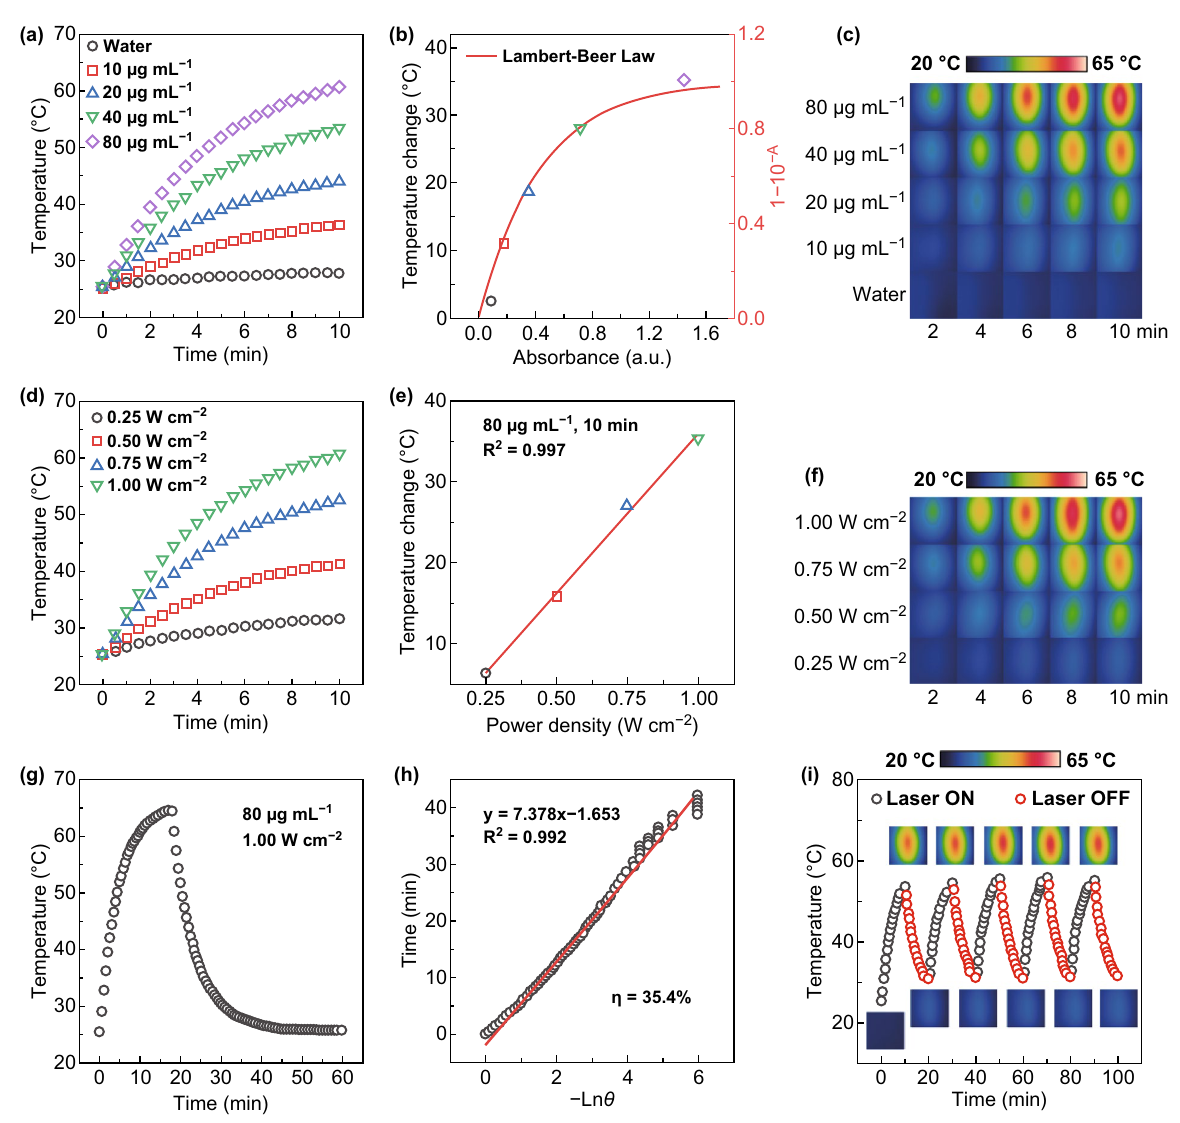
Fig. 2 Photothermal effect of IID-ThTPA NPs. a Photothermal heating curves of IID-ThTPA NPs with different concentrations (671 nm, 1.00 W cm −2 ). b Plot of the temperature changes of IID-ThTPA NPs versus the absorbance at different concentrations with a fitted curve derived from Lambert–Beer law. c Infrared thermographs of IID-ThTPA NPs with different concentrations under laser irradiation at various time points (671 nm, 1.00 W cm −2 ). d Photothermal heating curves of IID-ThTPA NPs (80 μg mL −1 ) under 671-nm laser irradiation with different power densities. e Plot of the temperature changes of IID-ThTPA NPs versus the laser power densities with a linearly fitted line. f Infrared thermo- graphs of IID-ThTPA NPs (80 μg mL −1 ) under 671-nm laser irradiation with different power densities at various time points. g Photothermal heating curve to calculate the photothermal conversion efficiency. IID-ThTPA NPs (80 μg mL −1 ) were irradiated by a 671-nm laser with a power density of 1.00 W cm −2 to reach a temperature plateau; then, the laser was shut off and the temperature was allowed to cool to room tempera- ture naturally. h Plot of linear time data from the cooling period of IID-ThTPA NPs versus negative natural logarithm of the driving force tem- perature ( θ ). i Photothermal heating curve of IID-ThTPA NPs (40 μg mL −1 ) for five laser on/off cycles under irradiation (671 nm, 1.00 W cm −2 ) (insets are the infrared thermographs of IID-ThTPA NPs at different time points during the laser on/off